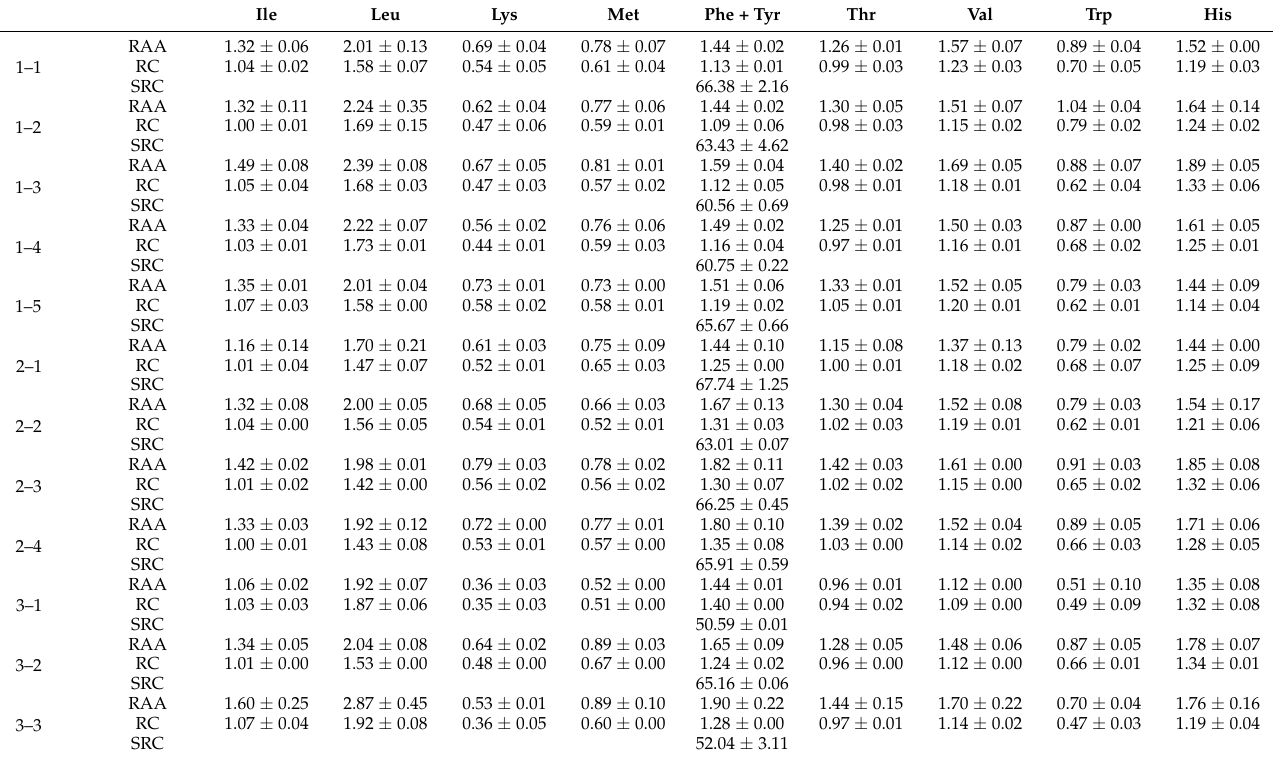
Table 11. RAA, RC, and SRC of IOM amino acid standard pattern spectra from three